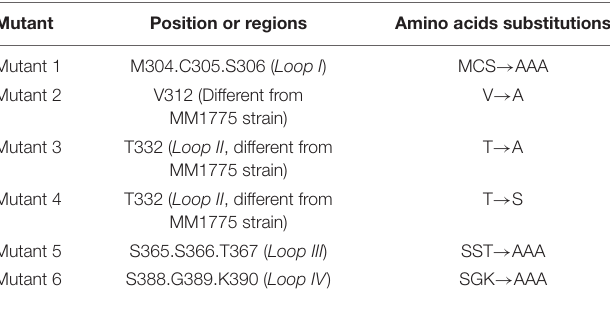
TABLE 2 | Mutations introduced into the Tembusu virus (TMUV) E protein. Mutant Position or regions Amino acids